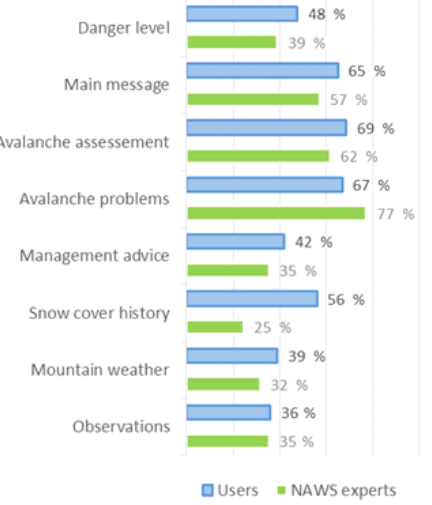
Figure 5. Factors the users and the NAWS experts considered most important in the avalanche warning on